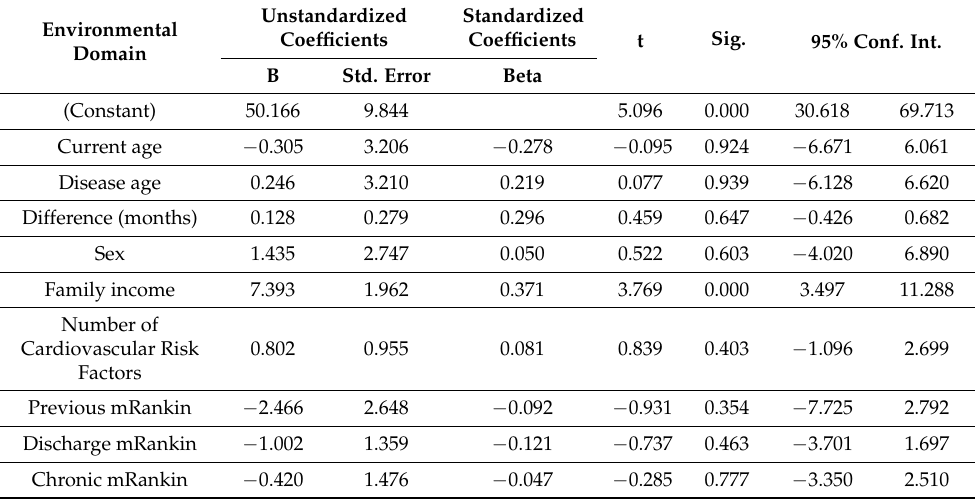
Table 8. Multivariate analysis for Environmental